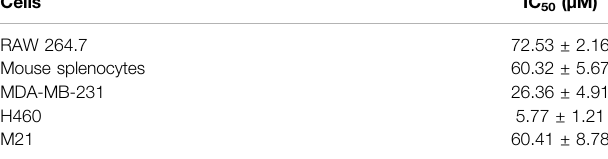
The results represent mean ± SEM, values from three separate experiments. RAW 264.7, mouse leukemic monocyte macrophage cells; H460, human lung adenocarcinoma cells; MDA-MB-231, human breast cancer cells; M21, human melanoma cells;IC50; half-maximum inhibitory